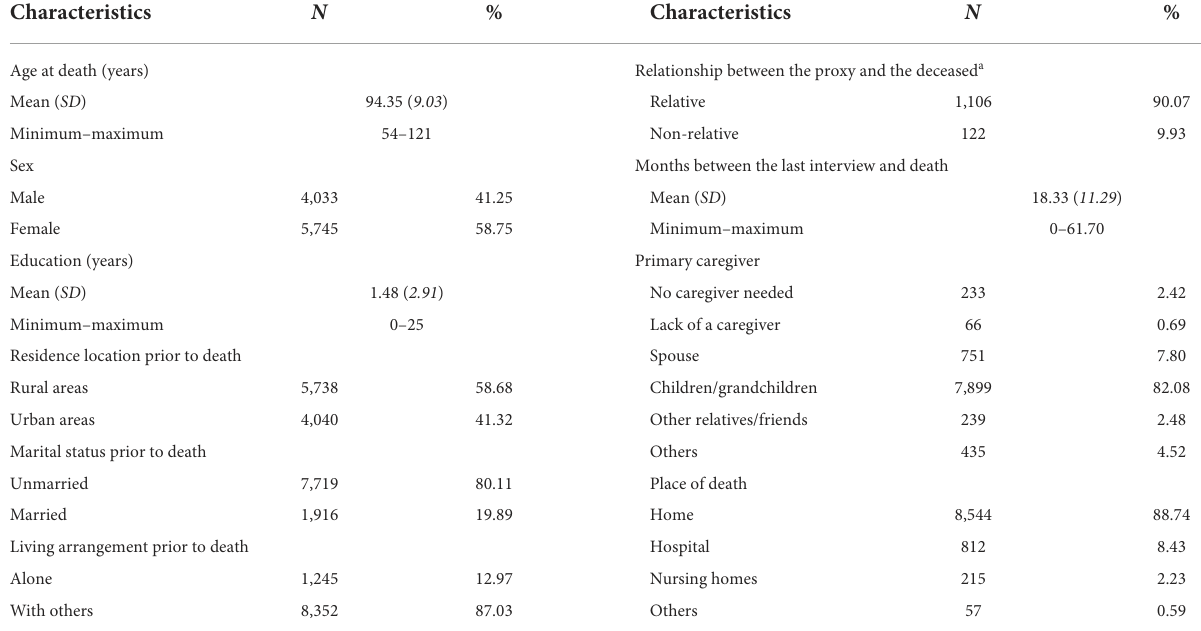
TABLE 1 Socio-demographic characteristics of subjects ( N = 9,778). Characteristics